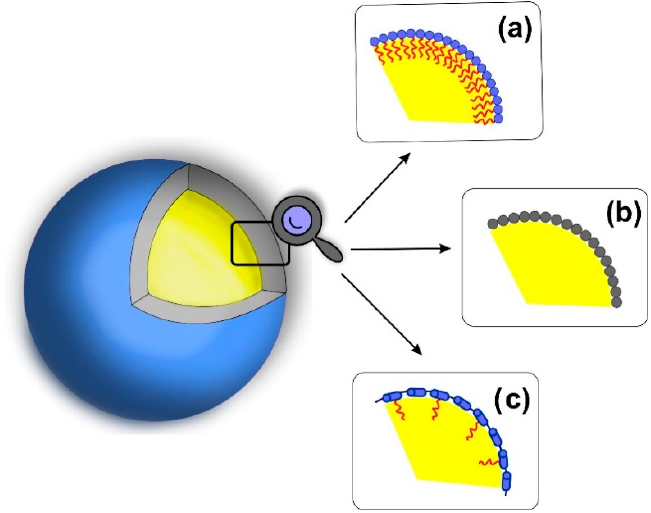
Figure 1. Different methods of stabilization of oil-in-water nanoemulsions using: ( a ) low molecular weight surfactants or block copolymers, ( b ) hard particles (Pickering emulsions), and ( c ) graft polymers.